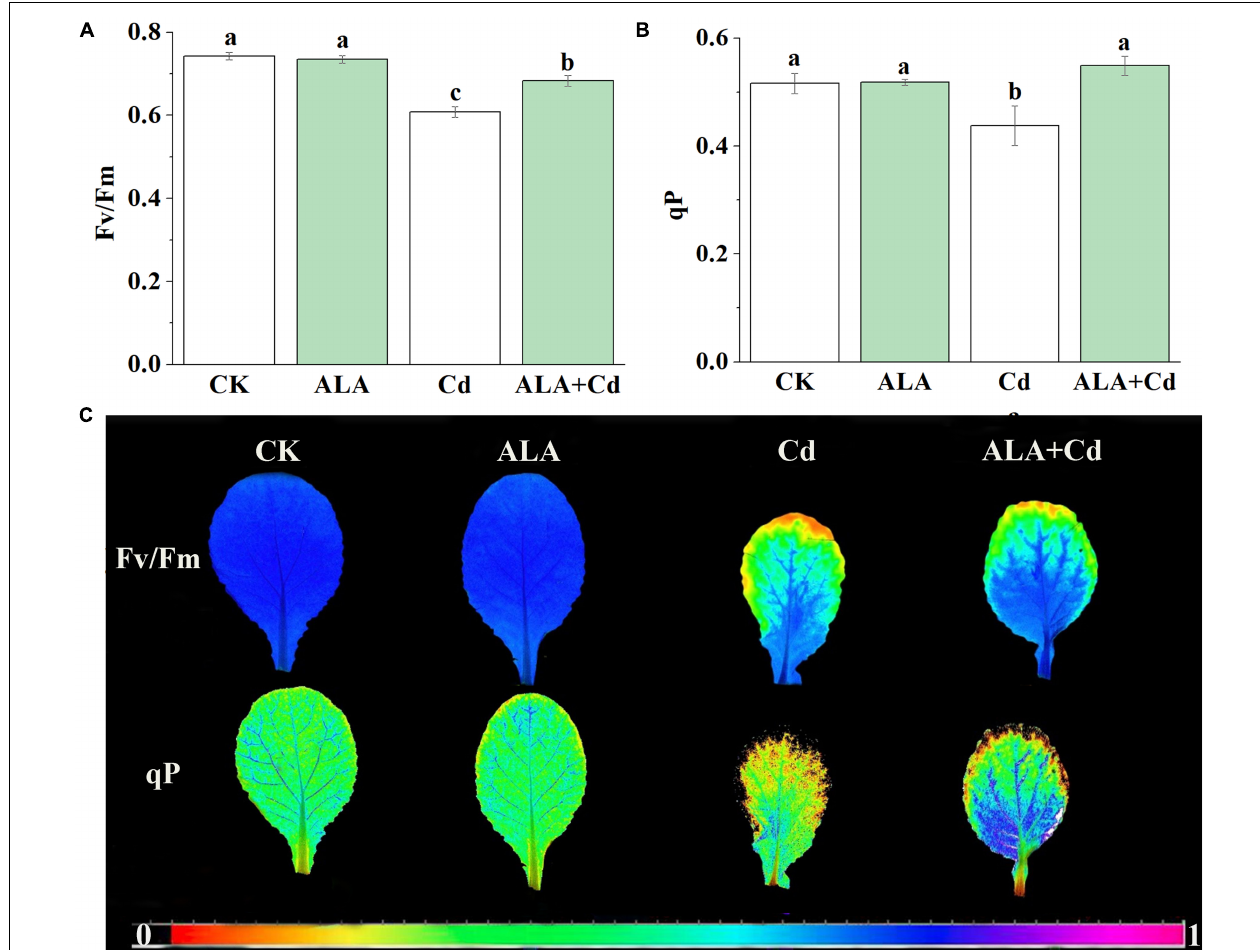
FIGURE 3 | Effects of ALA under Cd stress on chlorophyll fluorescence parameters of cabbage. (A) The maximum PSII quantum yield (Fv/Fm), (B) photochemical quenching coefficient (qP) and (C) Chlorophyll fluorescence imaging. The seedlings were treated as in Figure 1 . The mean ± SE are shown ( n ≥ 3). Different letters indicate significant difference among the treatments ( P <